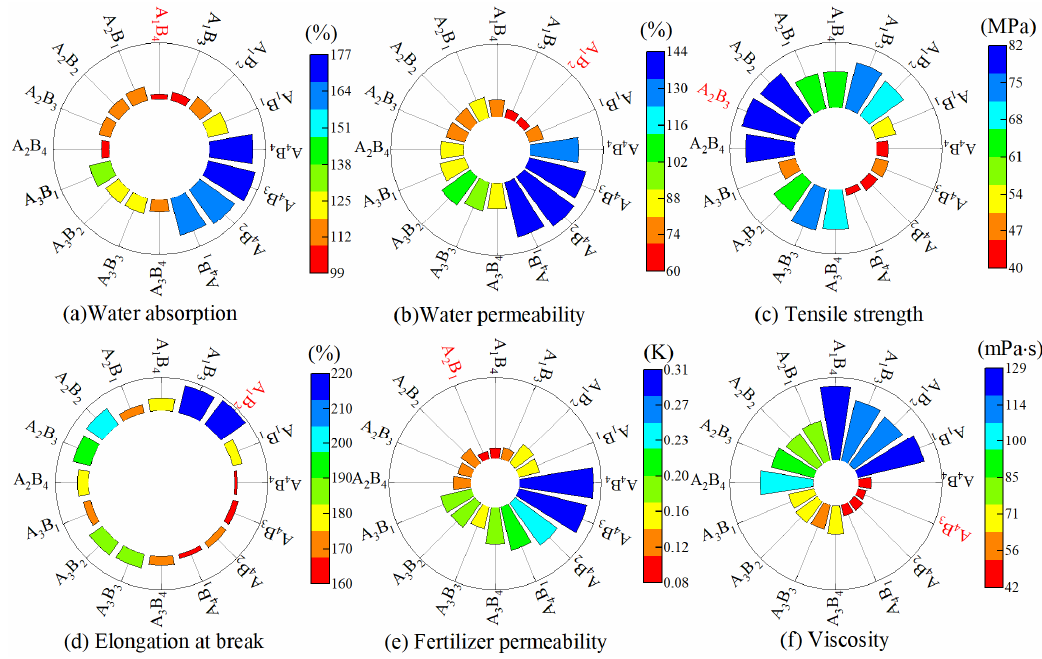
Figure 1. Parameters of physicochemical properties of membrane materials.